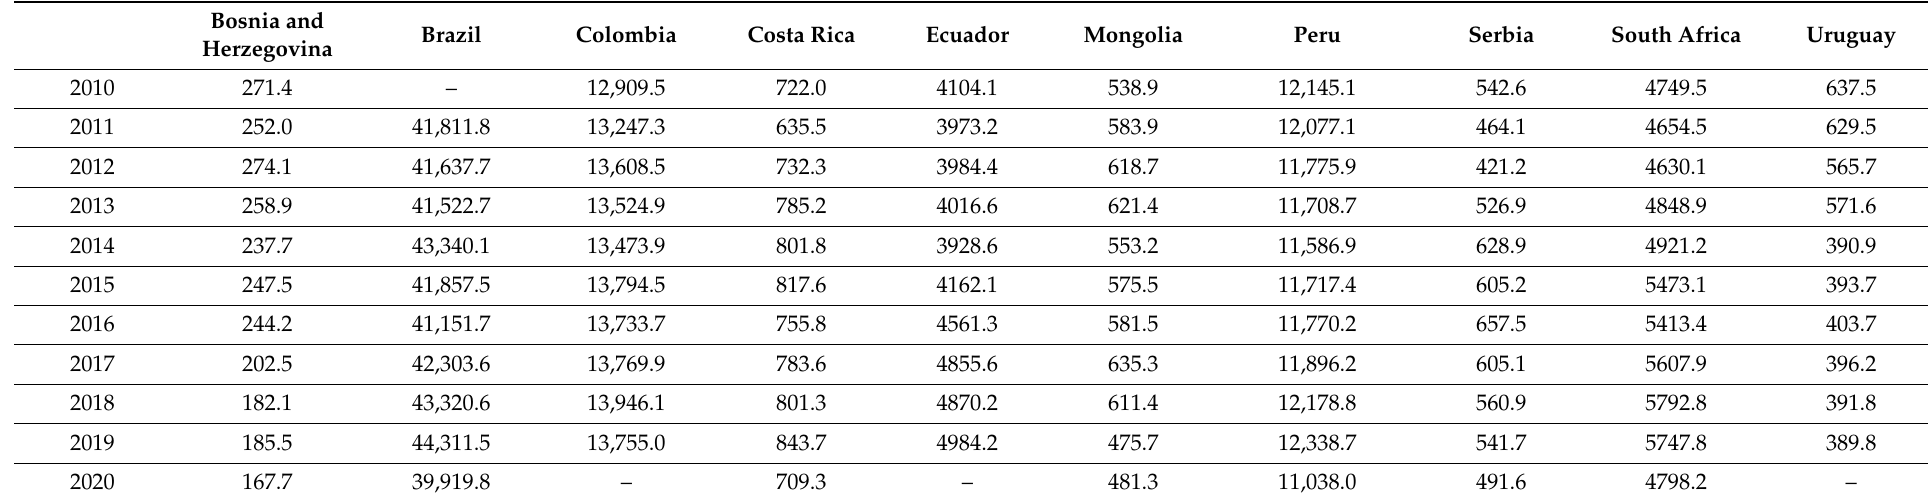
Table 3. Informal employment